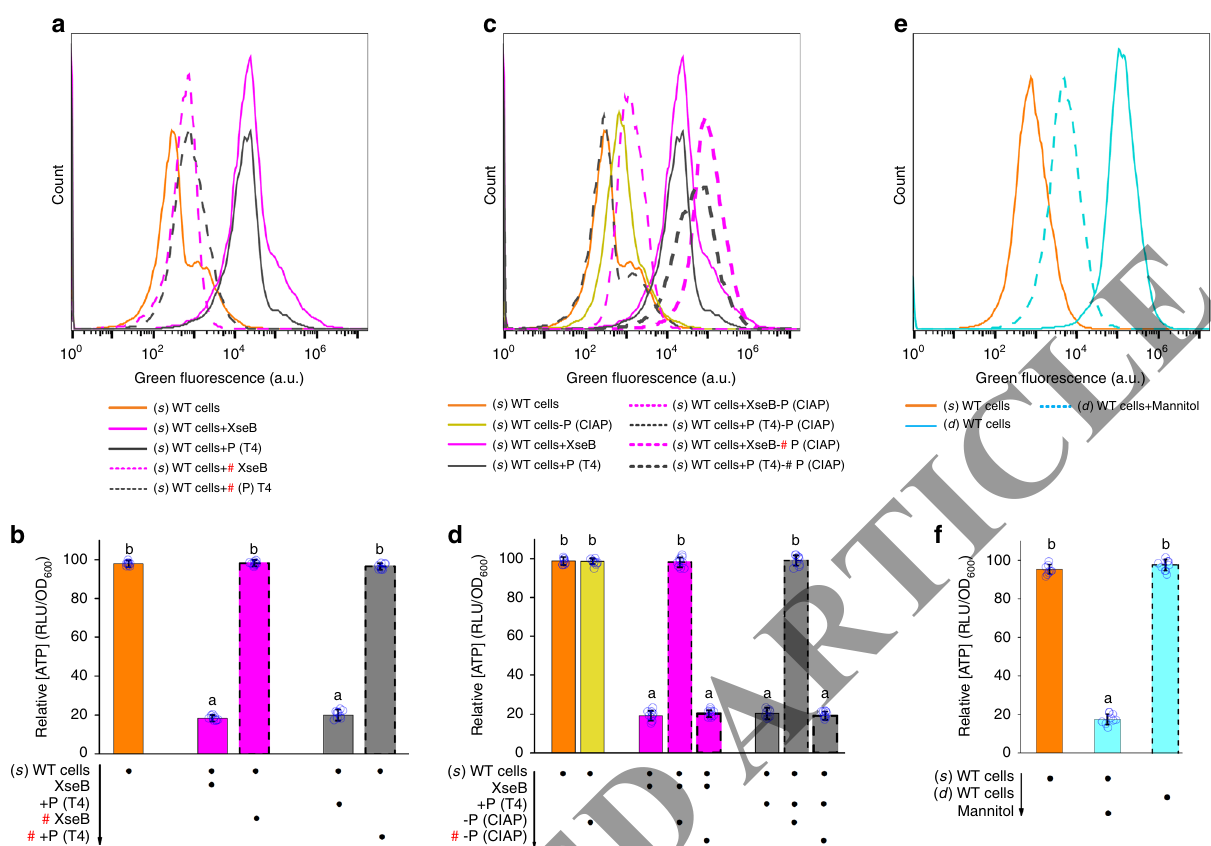
Fig. 5 PMF and intracellular ATP levels during complex switching. a , b PMF and intracellular ATP levels of ( s ) WT cells plus recombinant XseB or T4 polynucleotide kinase. c , d PMF and intracellular ATP levels of XseB-treated ( s ) WT cells or T4 polynucleotide kinase-treated ( s ) WT cells, both of which were treated with CIAP. Addition of CIAP did not affect PMF of ( s ) WT cells. e , f PMF and intracellular ATP levels of ( s ) WT cells, ( d ) WT cells, or ( d ) WT cells plus D -mannitol. All experiments were performed in biological triplicates. Error bars represent standard deviations. Dot plots overlaid on bar graphs represent individual data points. Black spot, treatment step or object; arrow, treatment order; hash sign, inactivated